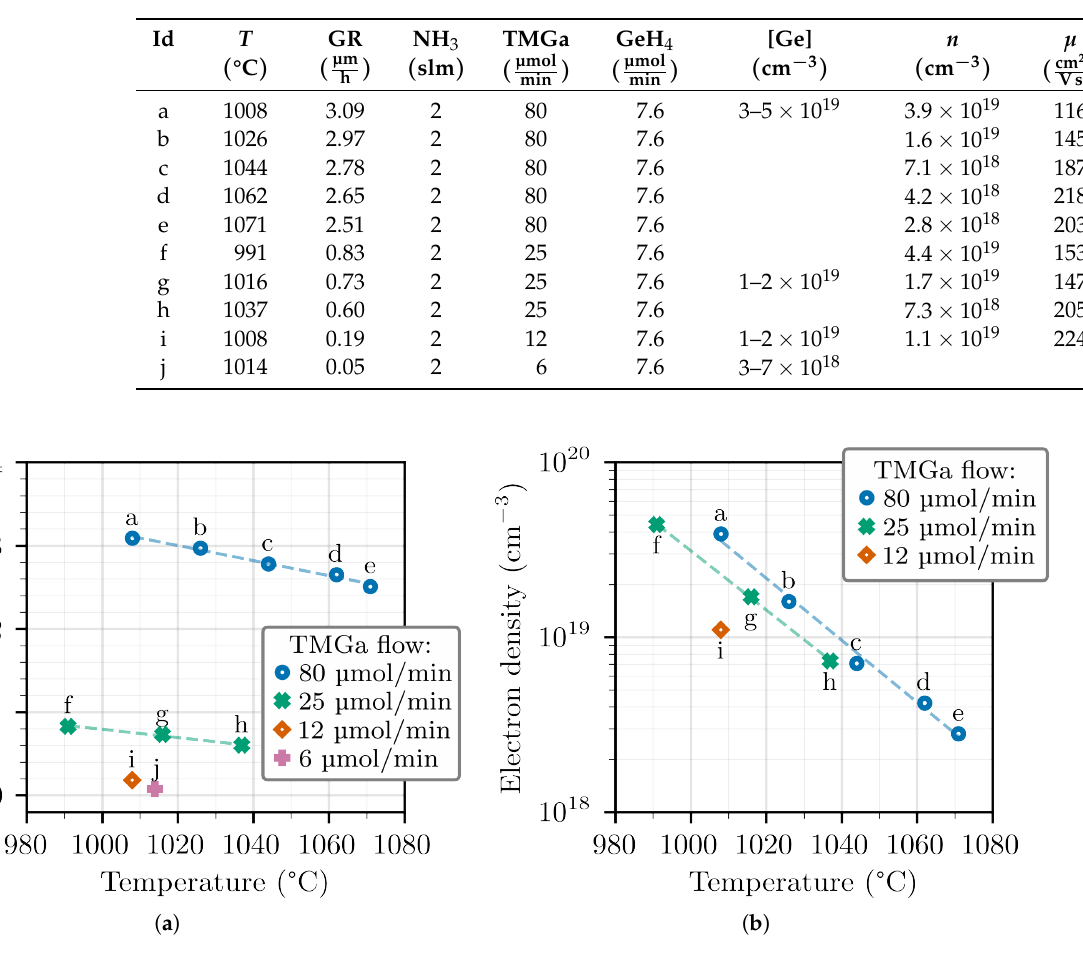
Figure 1. Growth rate (GR) ( a ) and electron density ( b ) for GaN:Ge layers grown at different temperatures and TMGa flows, while the NH 3 and GeH 4 flows are kept at 2slm and 7.6µmol/min, respectively. The dashed lines are linear fits to the